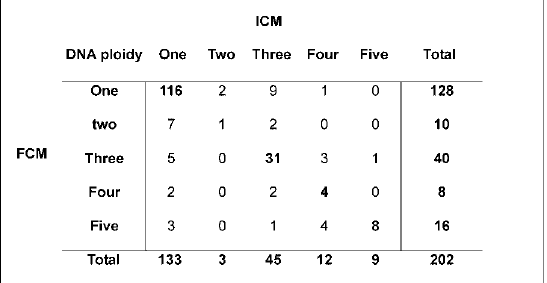
Table 1. Urothelial cell carcinomas (UCs). Confusion table for the distribution of ploidy classes into 5 groups for DNA flow